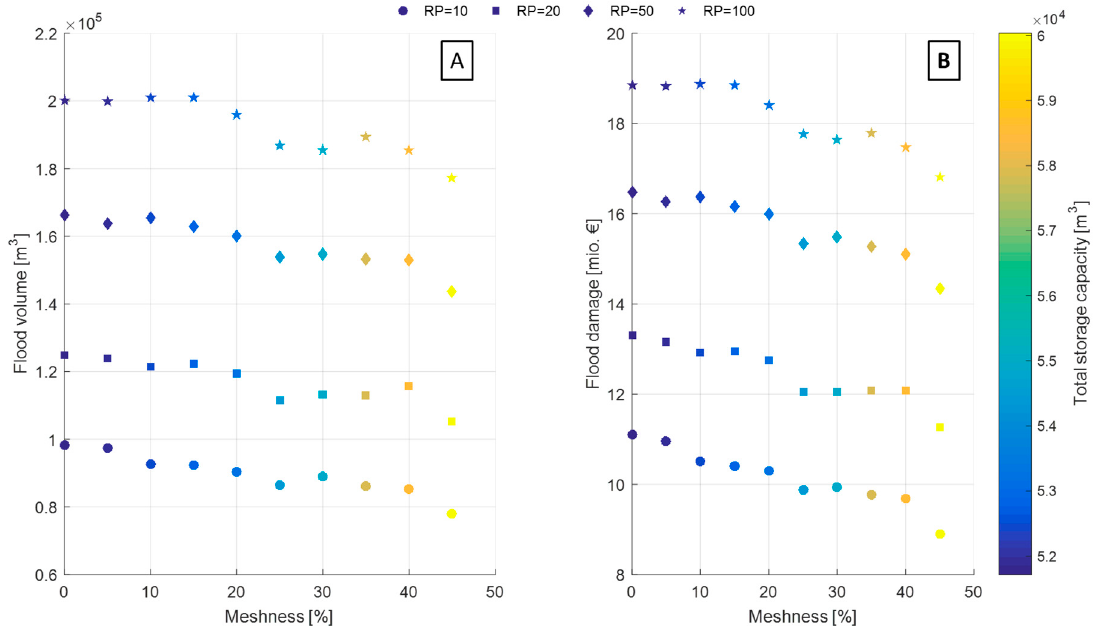
Figure 2. Flood volumes ( A ) and flood damages ( B ) for the different rain events as a function of Meshness, including the total storage capacity of the system for each analyzed Meshness degree.